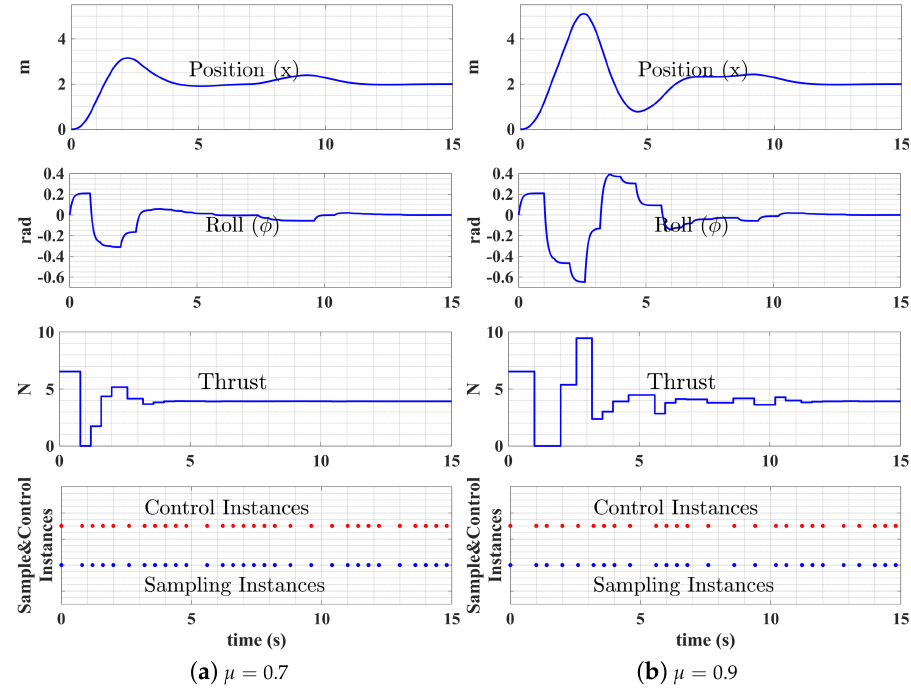
Figure 8. Self-triggered control performances with different µ